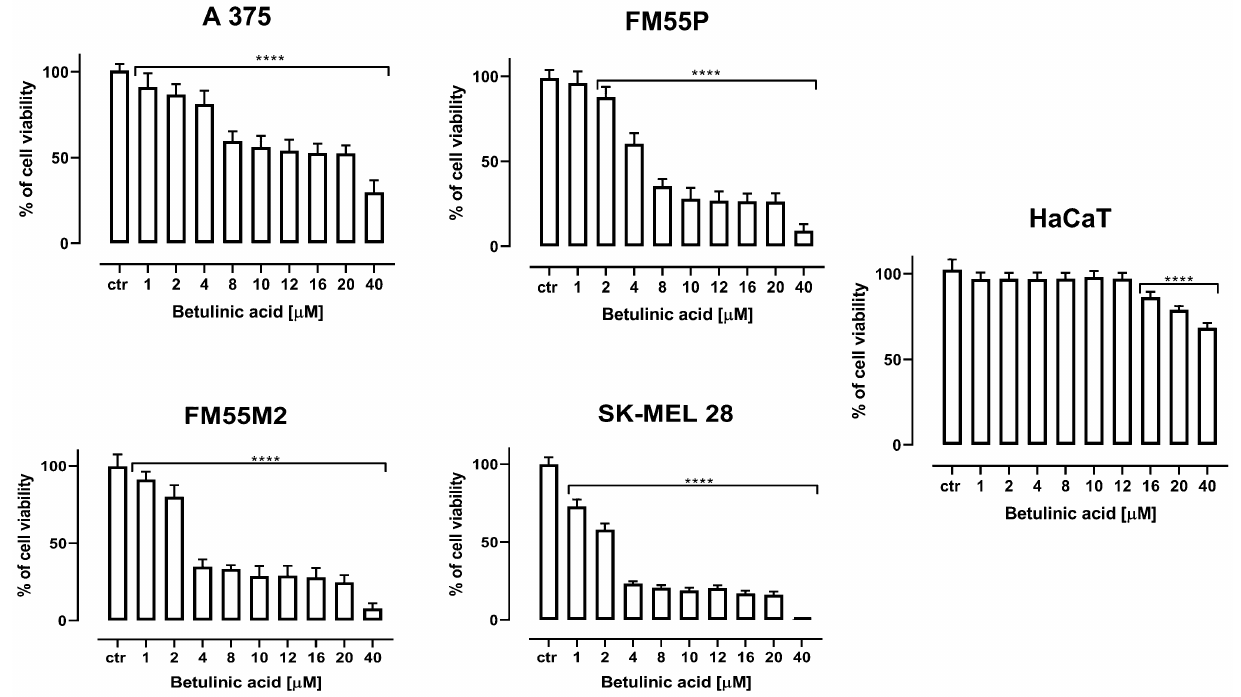
Figure 1. The effect of betulinic acid (BA) on the viability of malignant melanoma cancer cell lines and normal human keratinocytes (HaCaT) cell lines was measured by MTT assay after 72 h. Results are presented as mean ± SEM at each concentration. (**** p < 0.0001).